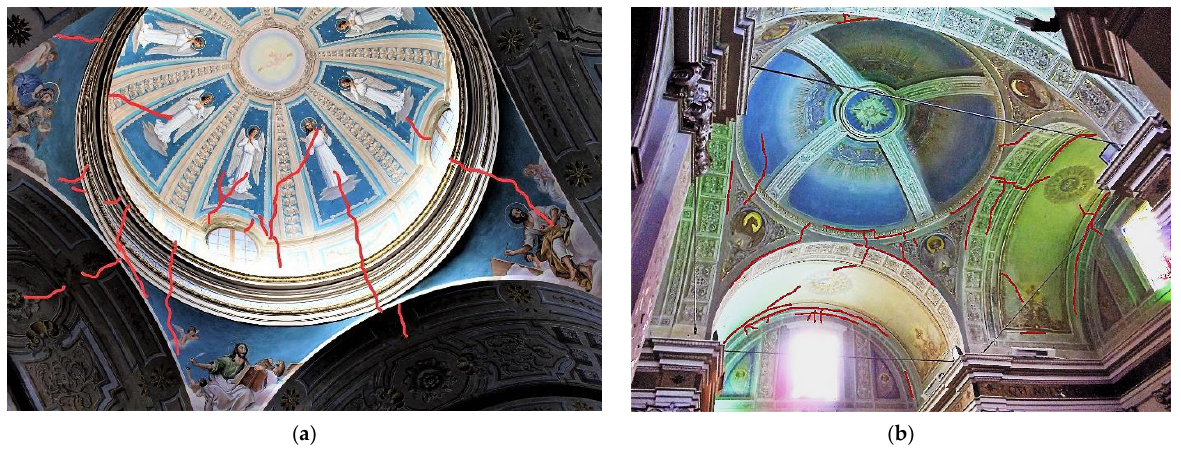
Figure 6. Different masonry typologies surveyed: ( a ) typical double-layer wall without headers (St.